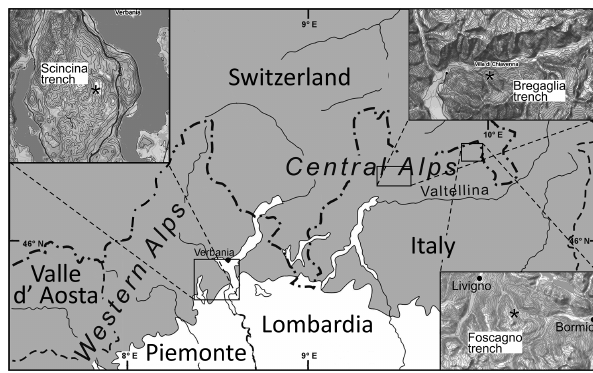
Figure 1. Location of the study areas in the context of the western and central Italian Alps.